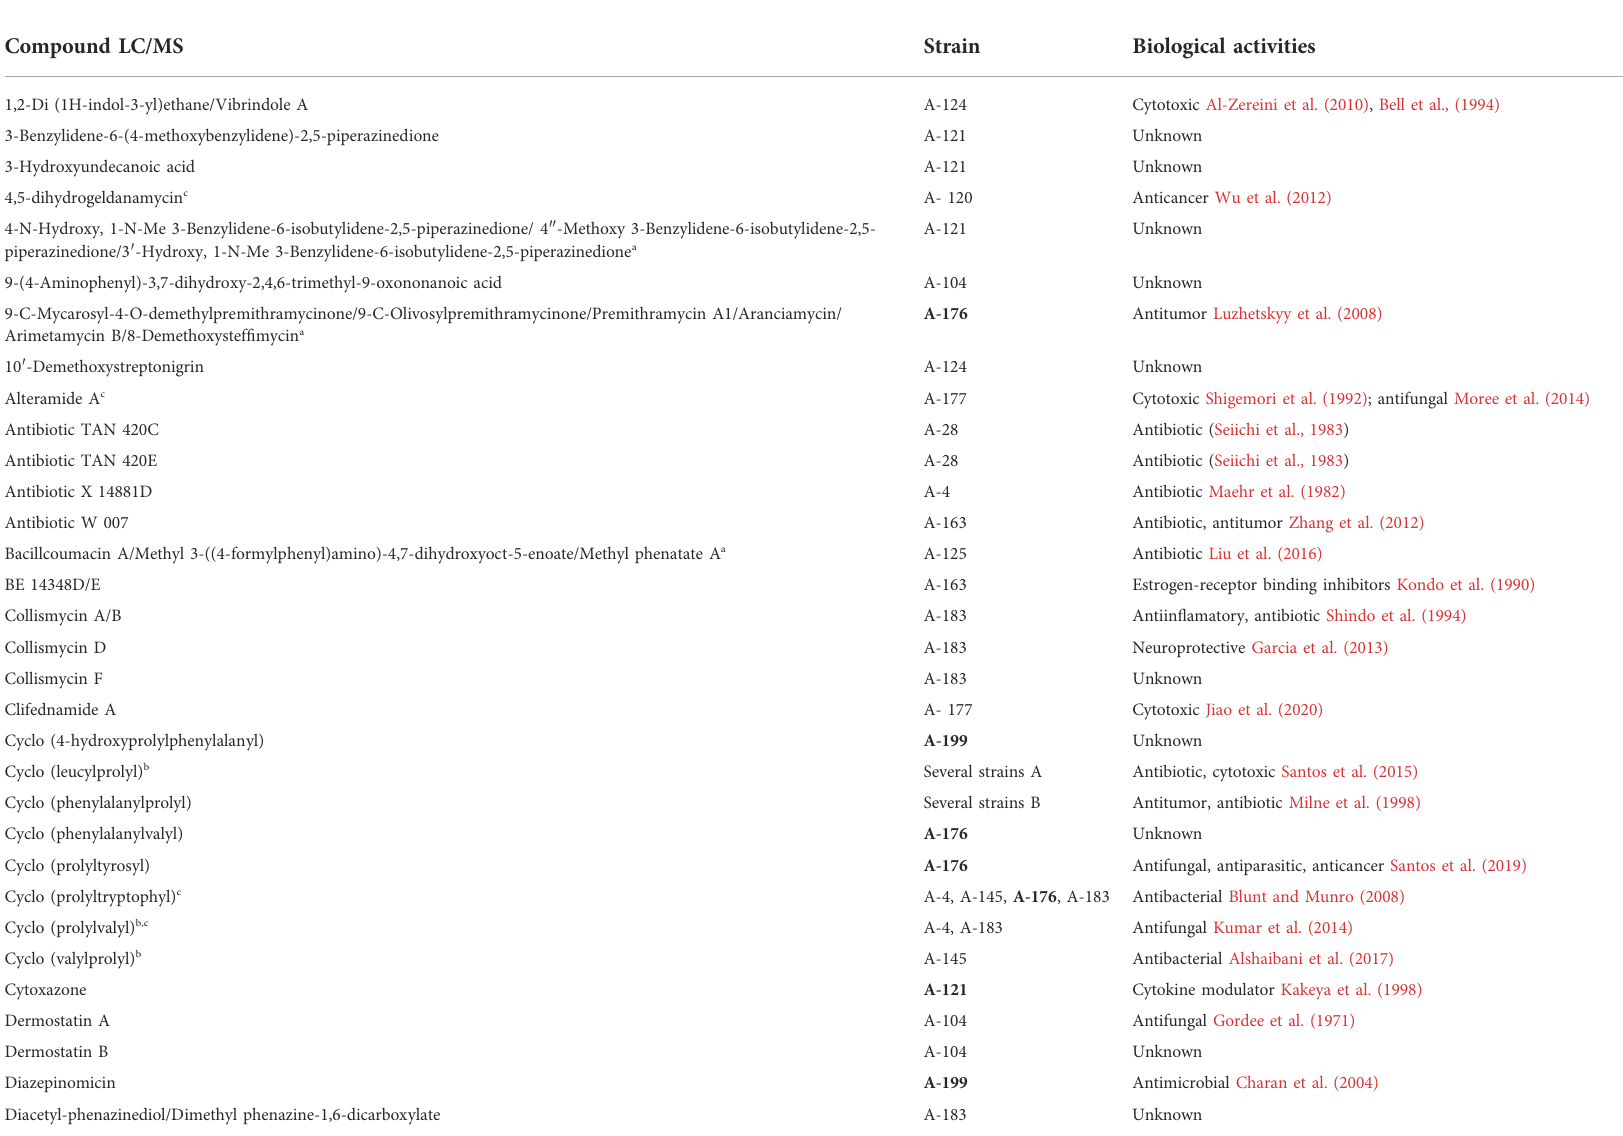
TABLE 3 Identi fi ed compounds produced by bioactive Streptomyces , Micromonospora and Nocardiopsis strains and their biological